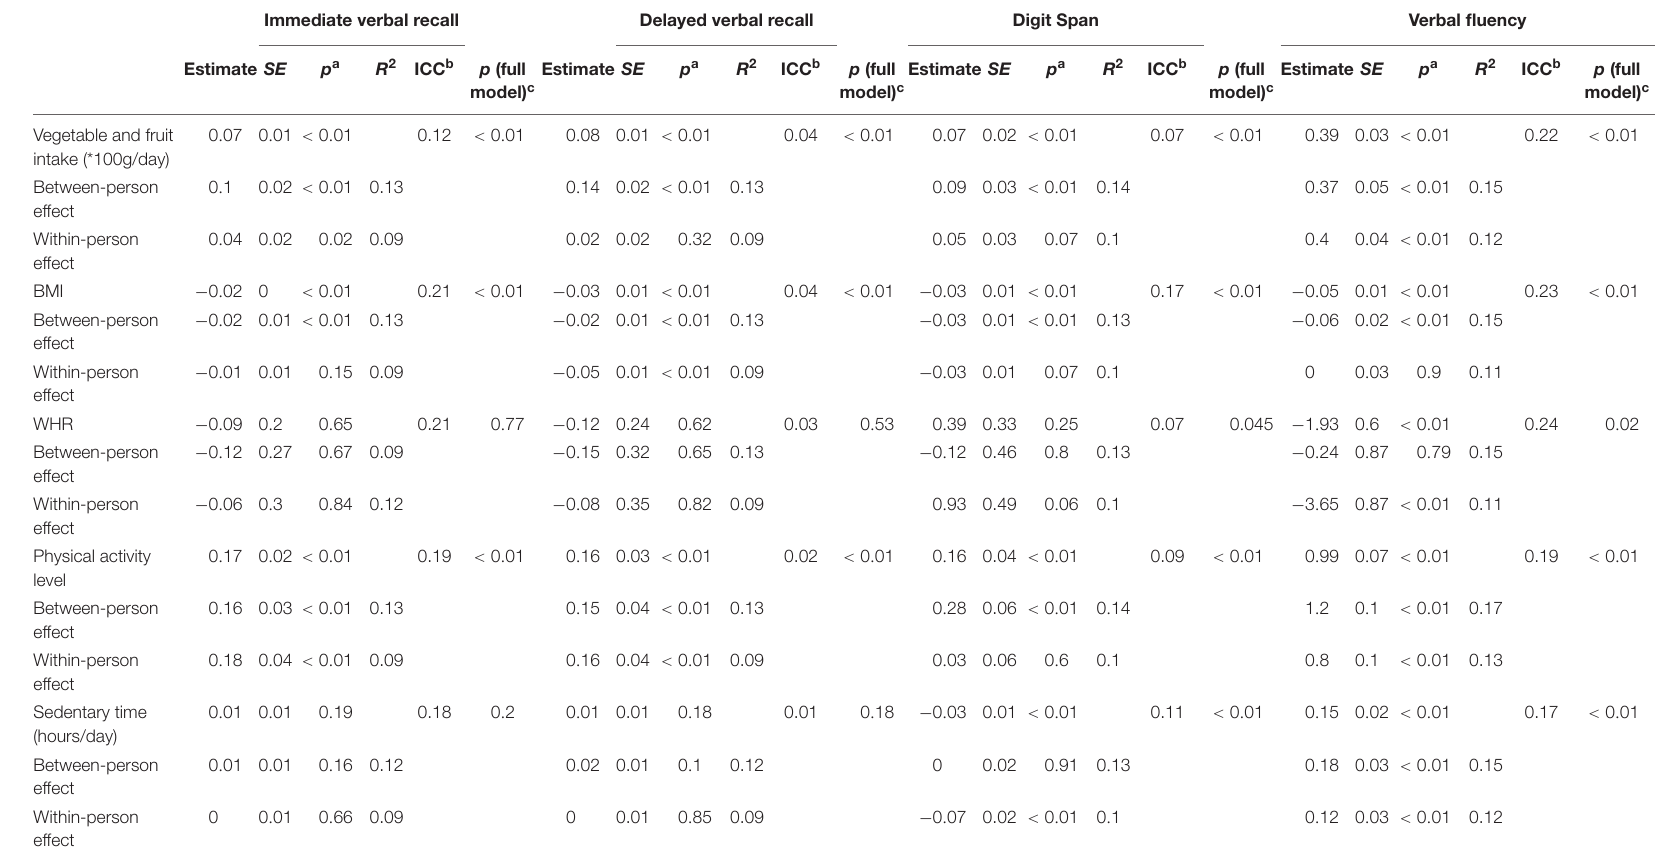
TABLE 3 | Contemporaneous associations between lifestyle factors and cognitive scores (between- and within-person effects). Immediate verbal